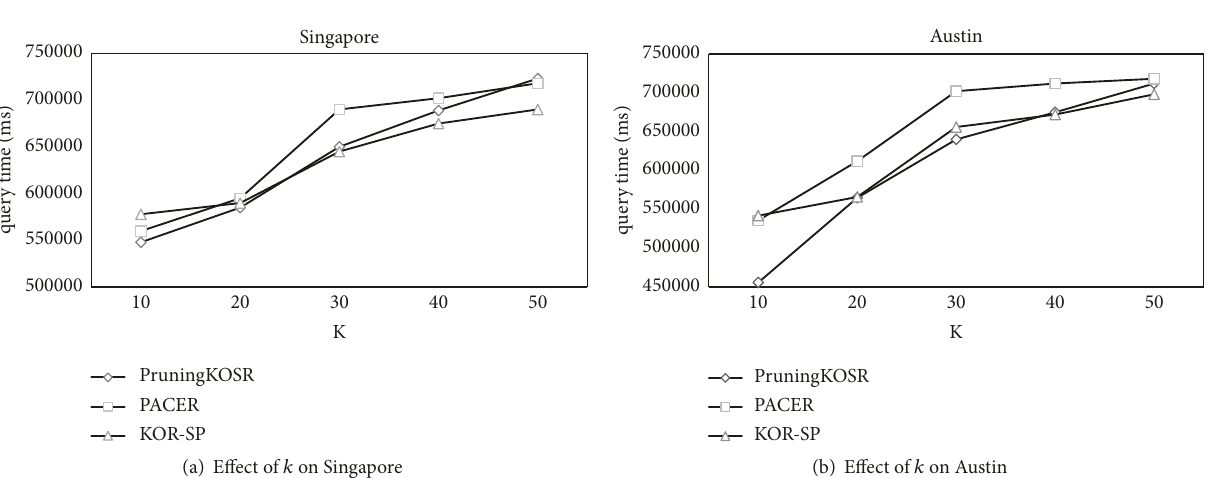
Figure 6: Route cost.